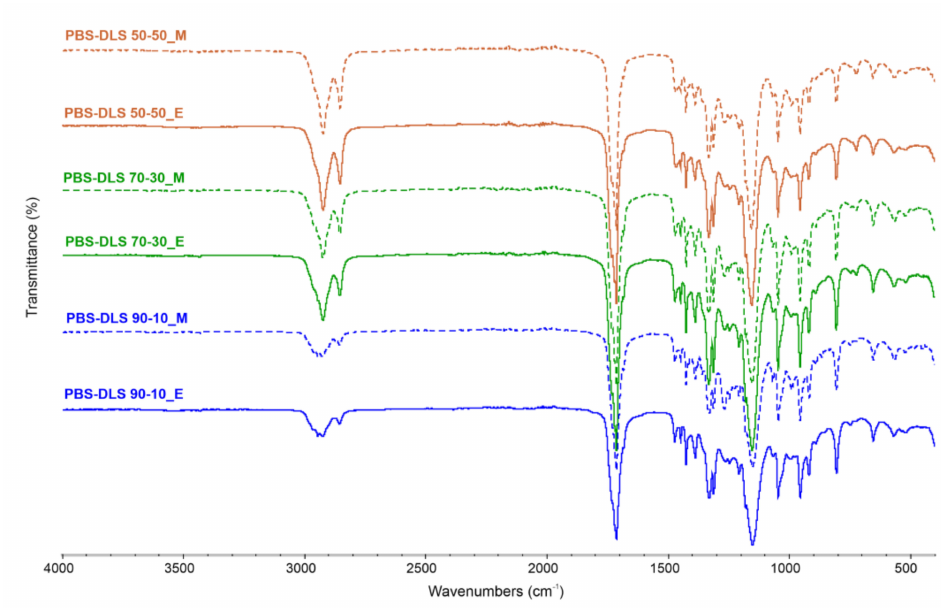
Figure 4. FTIR spectra of PBS-DLS